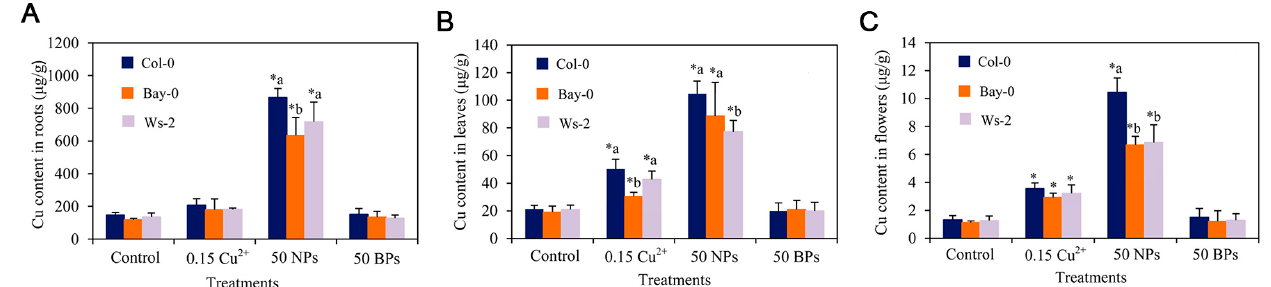
Figure 8. Cu contents in ( A ) roots, ( B ) leaves and ( C ) flowers of different Arabidopsis ecotypes after treatment with distilled water (control), 0.15 mg/L Cu 2+ ions (0.15 Cu 2+ ), 50 mg/L CuO NPs (50 NPs) and 50 mg/L CuOBPs (50 BPs). Significant difference among different treatments compared control was marked with “*”. For a given treatment, different letters represent significant differences among different ecotypes ( p < 0.05, LSD, n = 3). Reprinted with permission from Ref. [38]. At low concentrations, CeO 2 NPs can promote growth, but at high concentrations (1 g/L), they induce glutathione metabolism (oxidative stress response) and inhibit chloro- phyll production and plant growth [42,82]. These changes in physiological levels are believed to be caused by the nanoparticles themselves, rather than by dissolved Ce 4+ , and are particle-specific